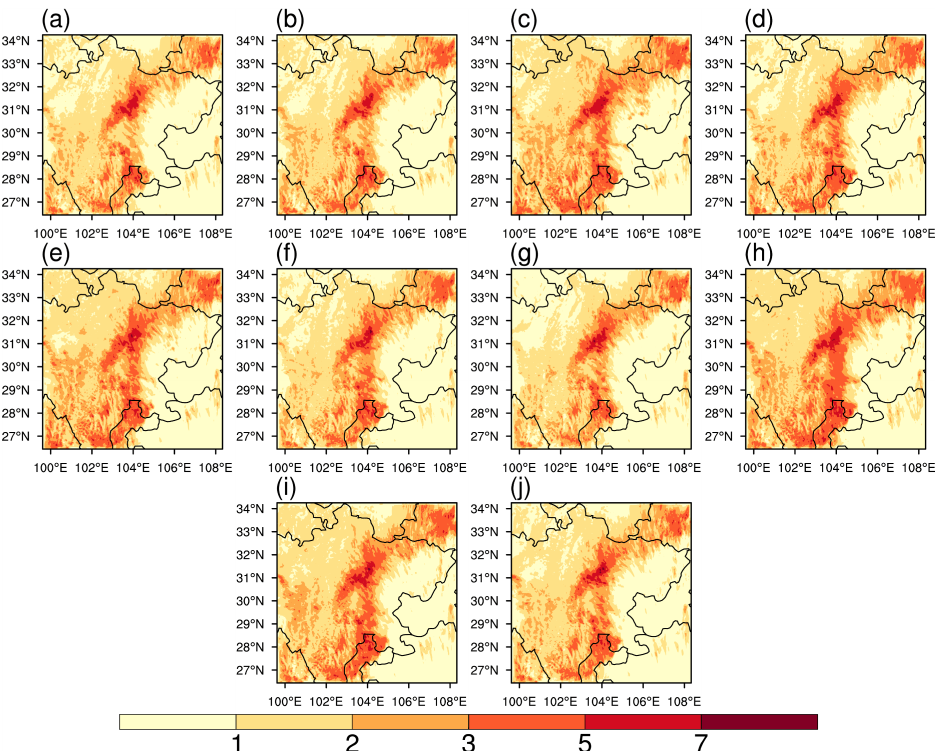
Figure 15. Similar to Figure 14, but for Case2. Panels from ( a – j ) show the results of parameter P1 to P10,